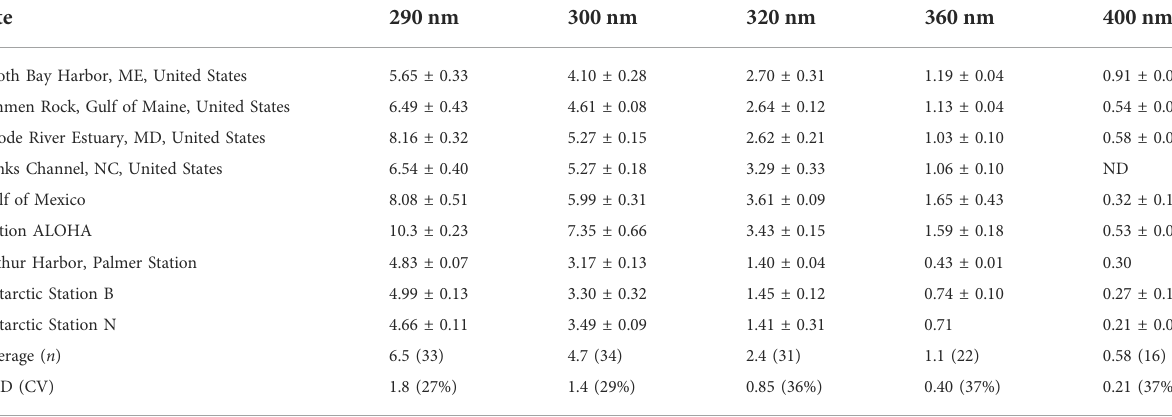
TABLE 2 Summary of marine H 2 O 2 Φ ( λ ) data [×10 – 4 mol/(mol photons)] determined at 25 ° C (Kieber et al., 2014) ± 1 SD, when available. ND is not determined.